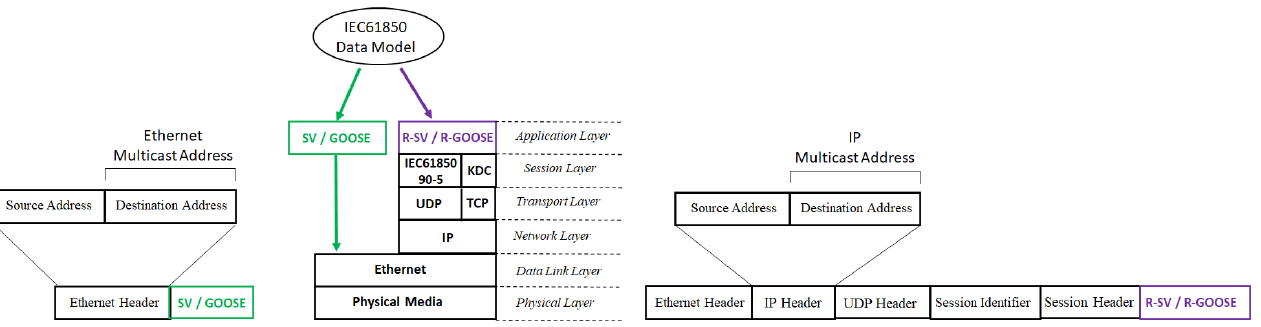
Figure 1. Frame structures of SV/GOOSE and R-SV/R-GOOSE.